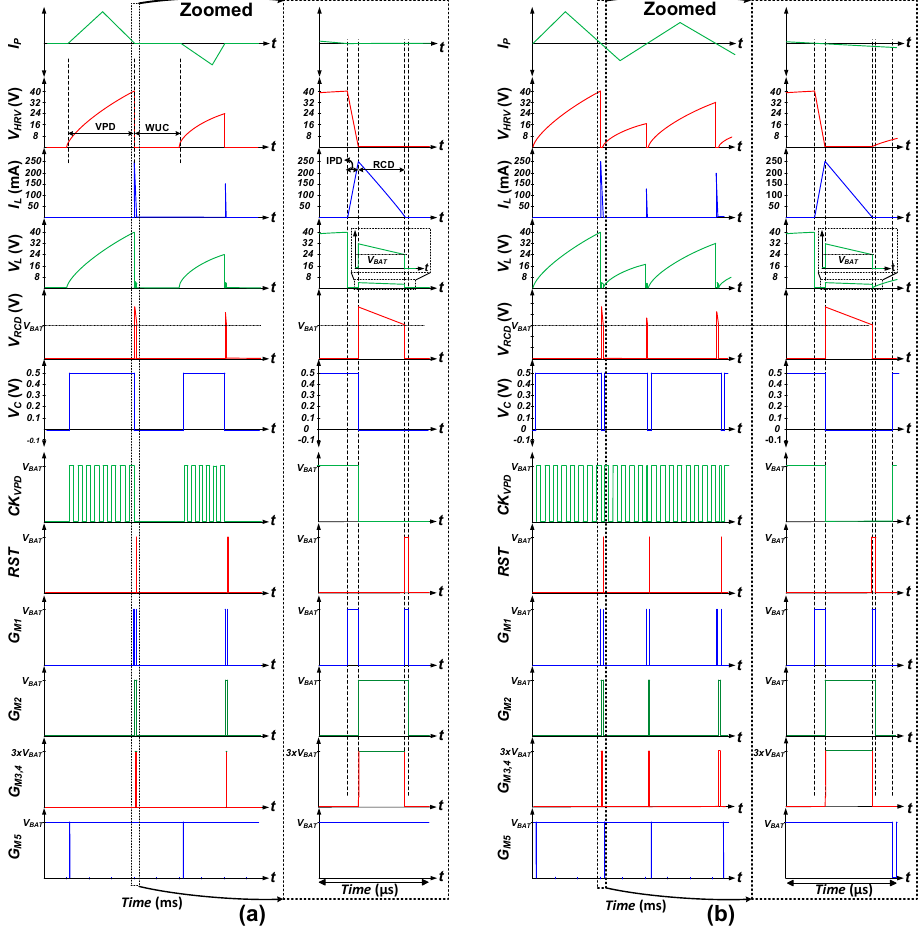
Figure 5. Proposed harvesting interface conceptual timing waveforms at ( a ) Discontinuous input harvesting and ( b ) Continuous input harvesting.